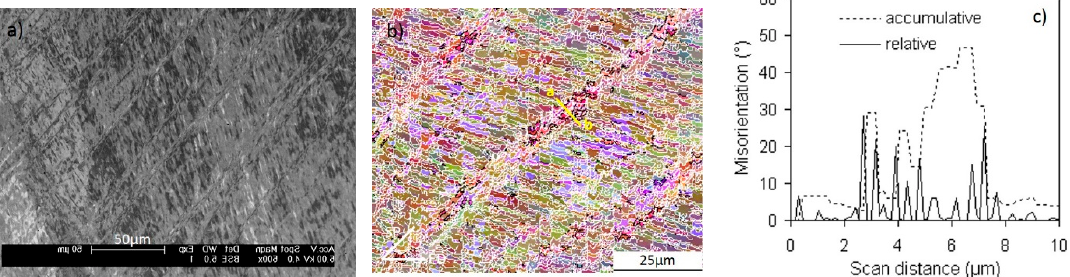
Figure 5. Characteristic features of shear bands formed in the 2nd pass; ( a ) FEGSEM backscatter image; ( b ) EBSD map and ( c ) a linescan of relative and accumulative boundary misorientations along ab in ( b ), demonstrating the generation of medium and high angle boundaries by shear banding.